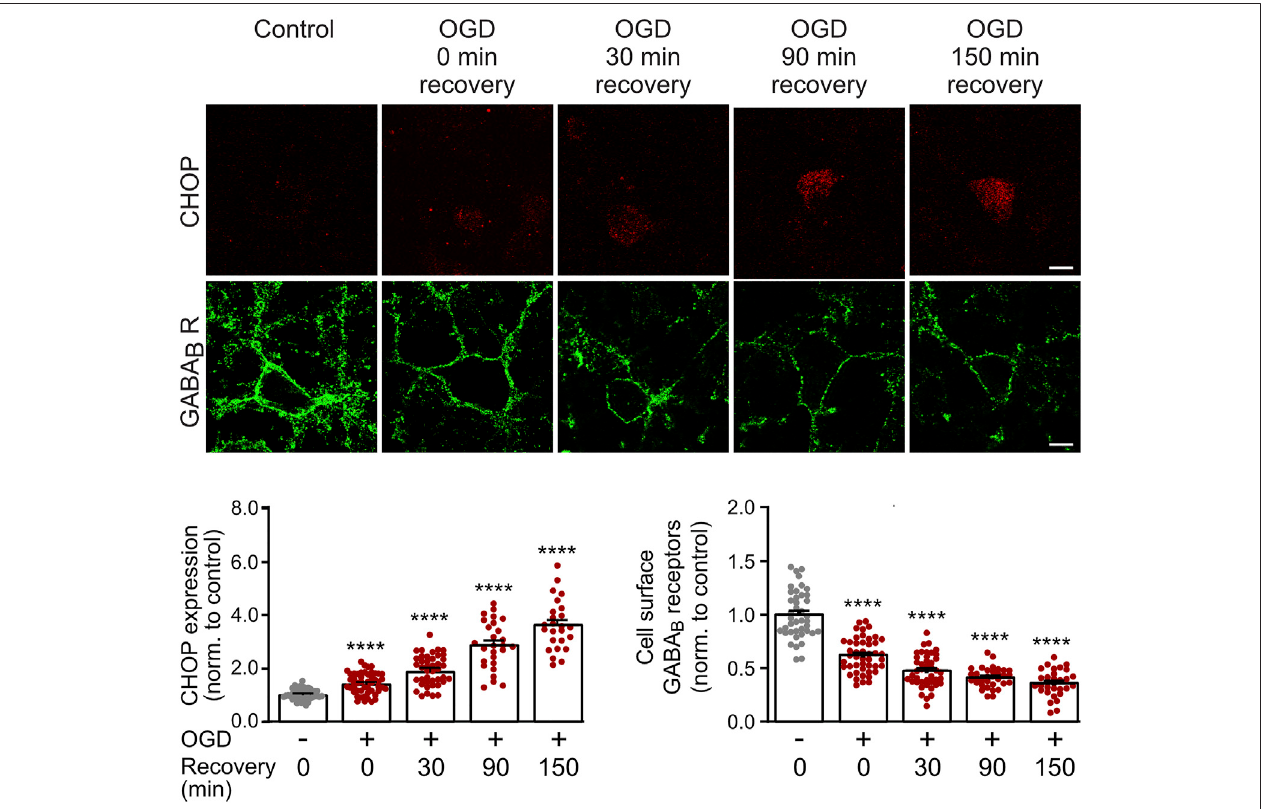
FIGURE1| Timecourse ofOGD-induced downregulation ofGABA B receptor cell surfaceexpression and CHOP upregulation. Neurons were exposed toOGD for 1 h, returned to the normal culture medium and tested for GABA B2 cell surface as well as CHOP expression at different time intervals (0, 30, 90 and 150 min) thereafter. Forthe0 minrecoverytime,thecultureswereremovedfromtheOGDmedium,washedonceinPBSfor2 minandthen fi xated.Top:representativeimages,thescalebar corresponds to 10 μ m. Bottom: quanti fi cation of fl uorescence intensities. Neurons not subjected to OGD served as a control. The data represent the mean ± S.E.M. of 31 – 46 neurons for each experimental condition derived from three independent experiments. ****, p ˂ 0.0001; Brown-Forsythe/Welch one-way ANOVA followed by Dunnett ’ s T3 multiple comparison test.